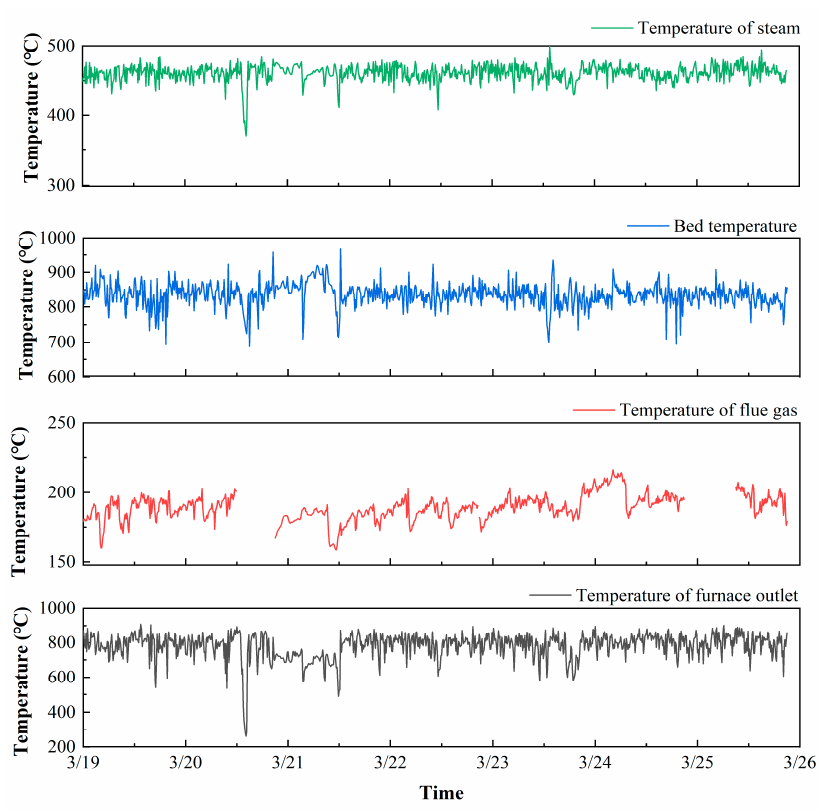
Figure 5. The trend for the temperatures of furnace outlet, bed, steam, and flue gas.